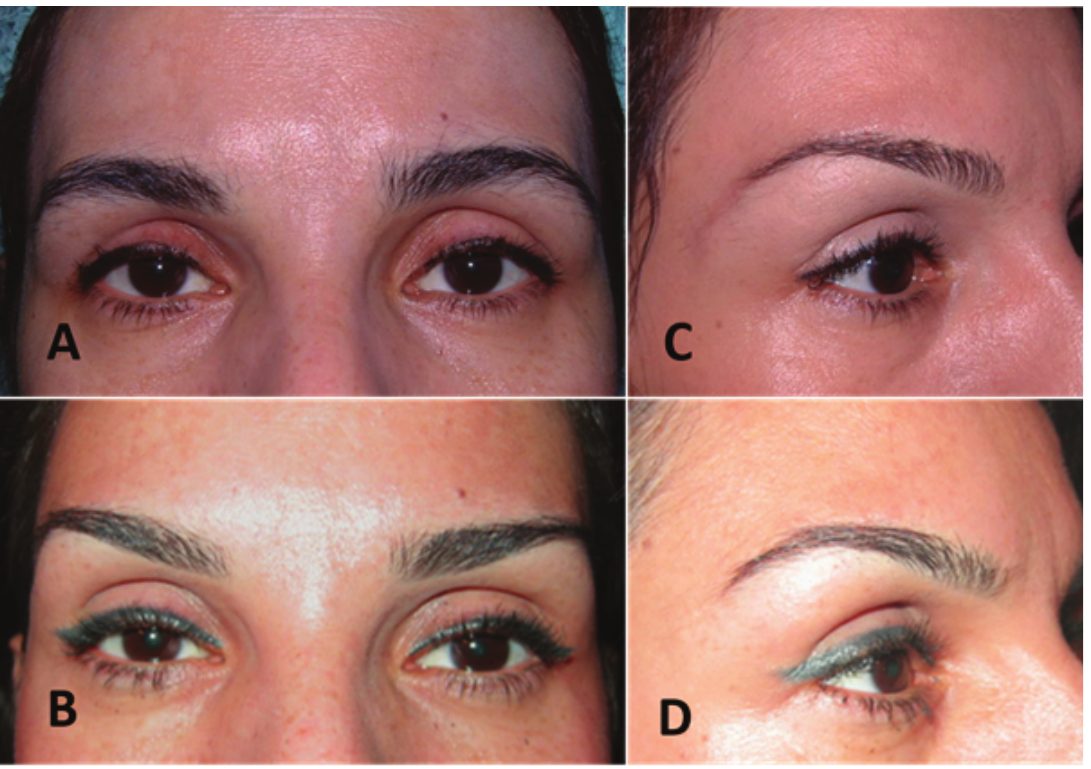
Figure 6. A very effective eyebrow tail lift with no visible scar (B & D) could be resulted from direct brow lift in female with high hairline (A &